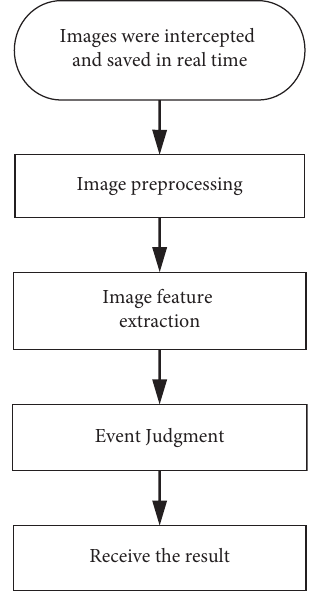
Figure 2: Power system image processing